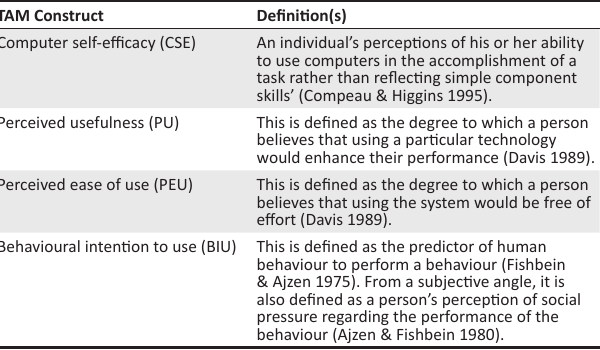
TABLE 1: Elements of the Technology Acceptance